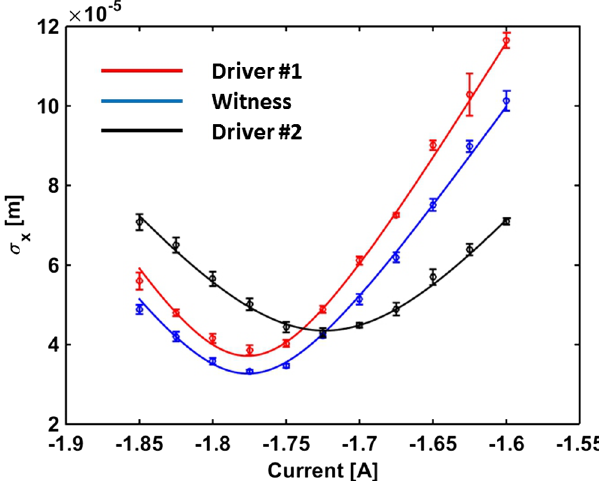
FIG. 8. Quadrupole scan on screen U3 with RFD on, in the horizontal plane. Here are reported the fits for every bunch in the train. It refers to the bunches shown in Fig.